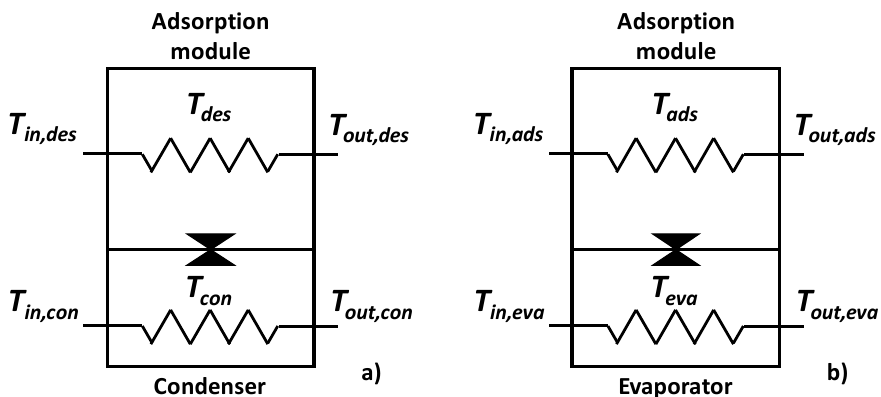
Figure 1. Boundary working conditions for seasonal thermal energy storage (STES) during ( a ) charging phase (i.e., summer season) and ( b ) discharging phase (i.e., winter season).